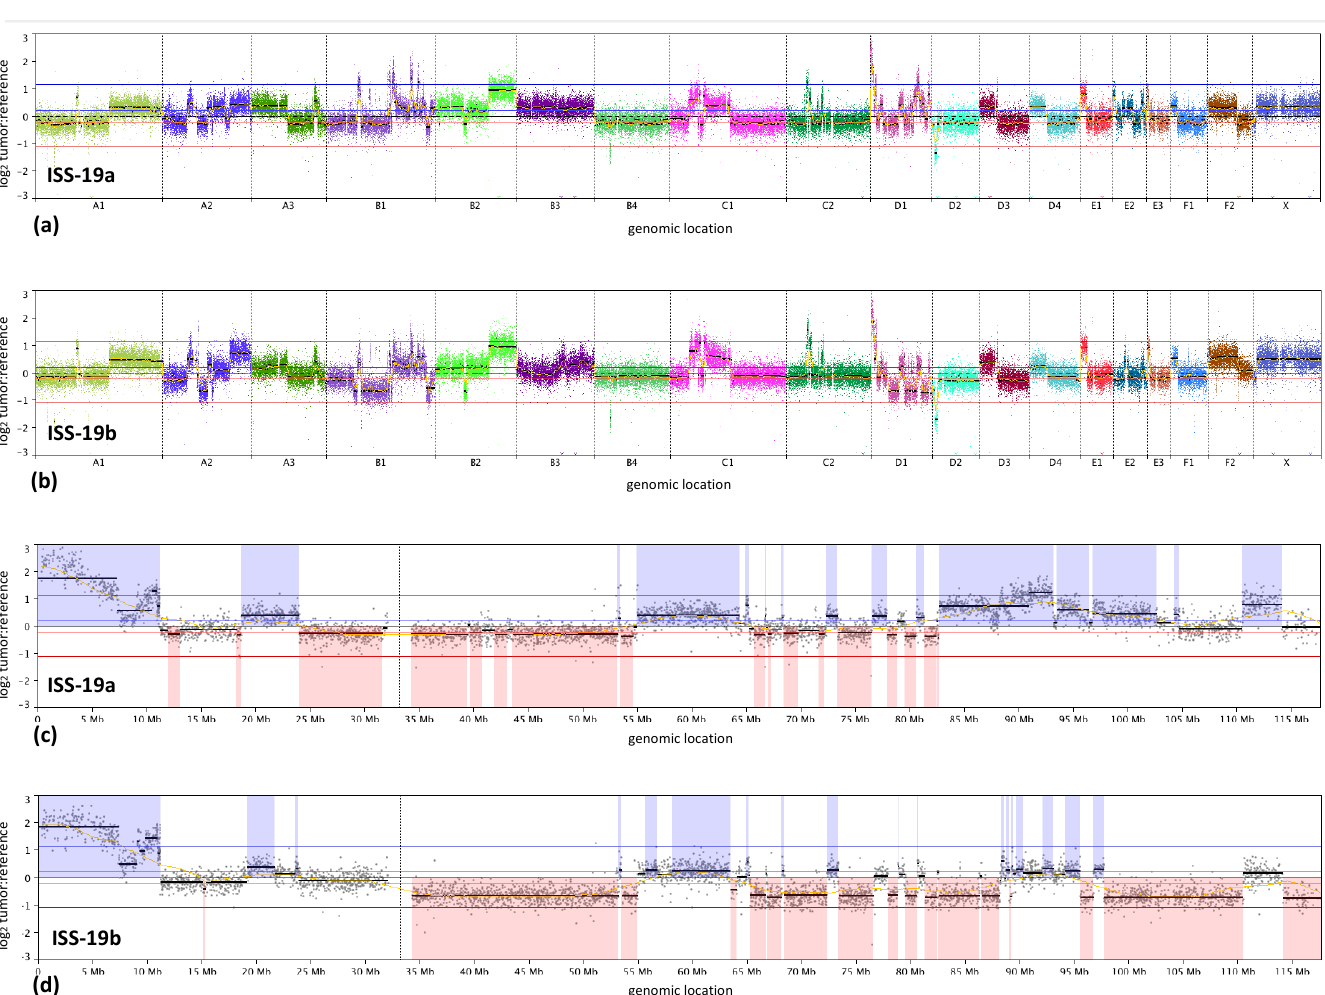
Figure 4. Genome-wide DNA copy number profiles derived from array-CGH analysis of ISS-19a and ISS-19b. ( a ) Genome-wide profile of the original tumor (ISS-19a) following resection. The tumor exhibits extensive copy number imbalance throughout the genome, evident as deviation from the horizontal midline, with only